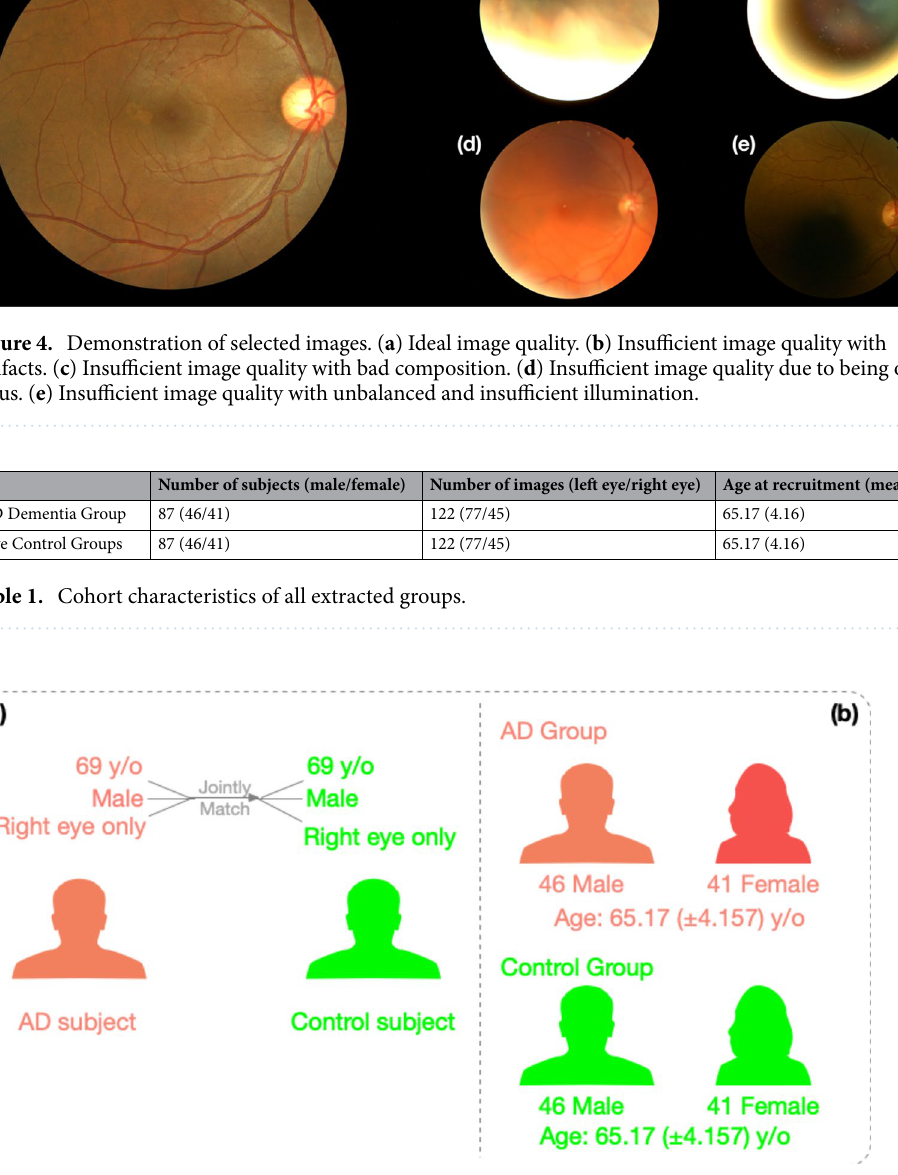
Figure 5. Control subjects were matched at the individual level. ( a ) For each AD subject, the matched healthy control subject was found with the identical combination of gender and age. ( b ) As a result, the control group and the AD group have identical distributions of gender and